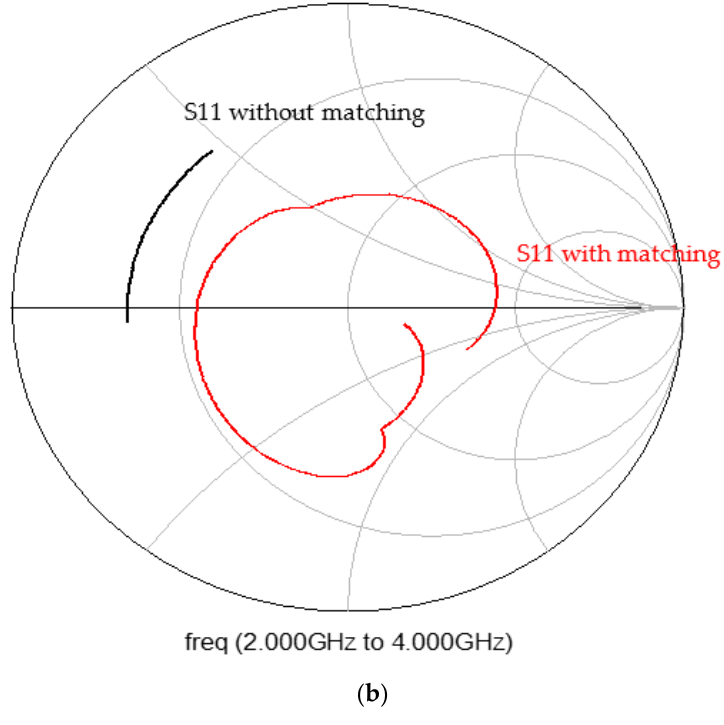
Figure 19. Receiving Circular Patch antenna: ( a ) Matching network; ( b ) S11 of the active antenna.